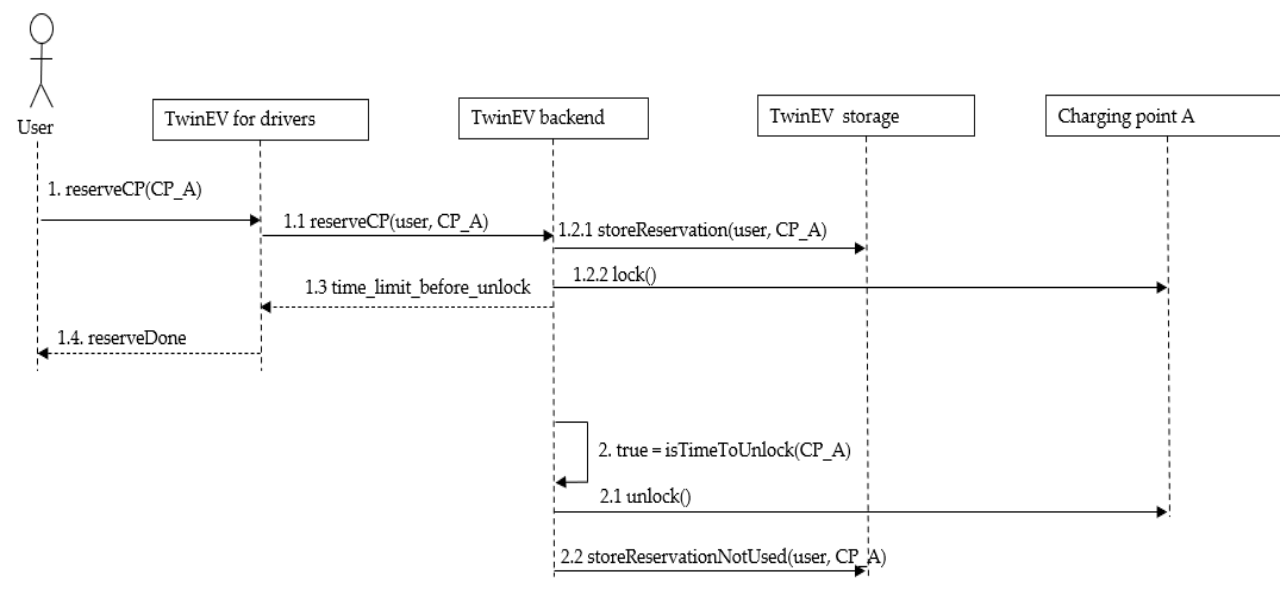
Figure 8. Reservation process when user finally does not charge his/her vehicle.